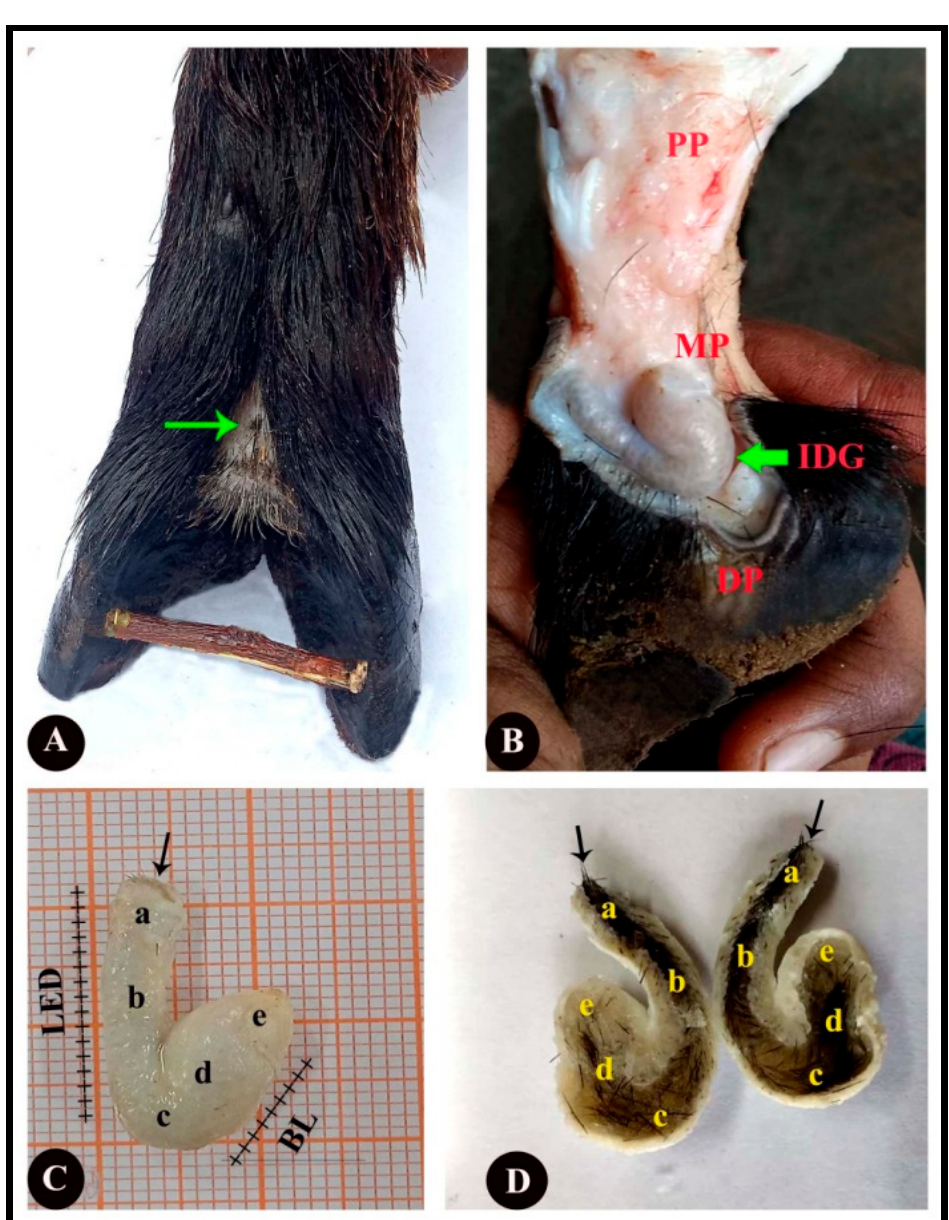
Figure 2. ( A ) Dorsal view of the interdigital region; the thin green arrow points to opening of the interdigital skin fold. ( B ) Medial view of the interdigital region; the thick green arrow points to the position of the sinus interdigitalis. IDG, interdigital gland. ( C ) The gland resembles a tobacco pipe in shape, with a wide body and long narrow neck. ( D ) Sagittal sectional view of the interdigital gland to show excretory duct filled with wooly fibers and its luminal content. a—orifice; b—excretory duct; c—flexure (distal part of the body); d—body of the sinus; e—fibrous attachment to the proximal part of the gland; BL—body length; LED—length of excretory duct; thin black arrow—external orifice; PP—proximal phalanx; MP—medial phalanx; DP—distal